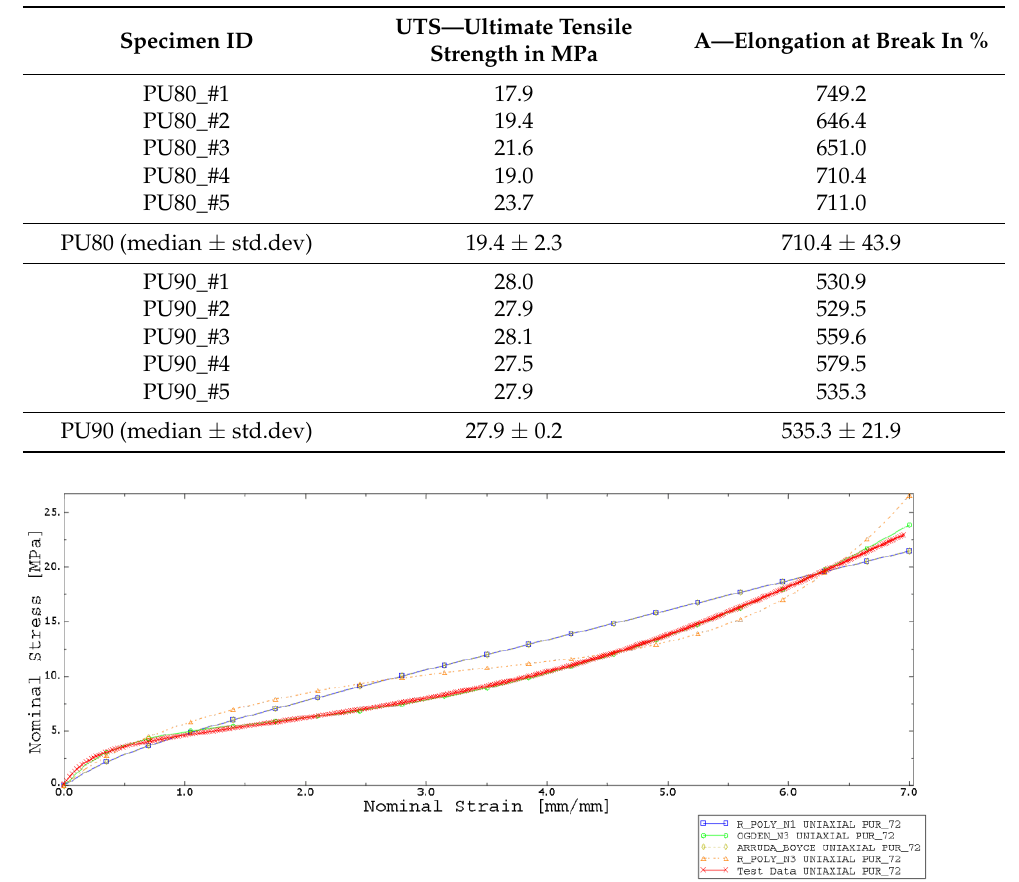
Figure 9. Stress – strain curves — experimental (red curve — test data) and numerical data fitting Figure 9. Stress–strain curves—experimental (red curve—test data) and numerical data fitting (Ogden, Arruda – Boyce, and reduced polynomial with 1 and 3 model parameters) for 80 ShA. (Ogden, Arruda–Boyce, and reduced polynomial with 1 and 3 model parameters) for 80